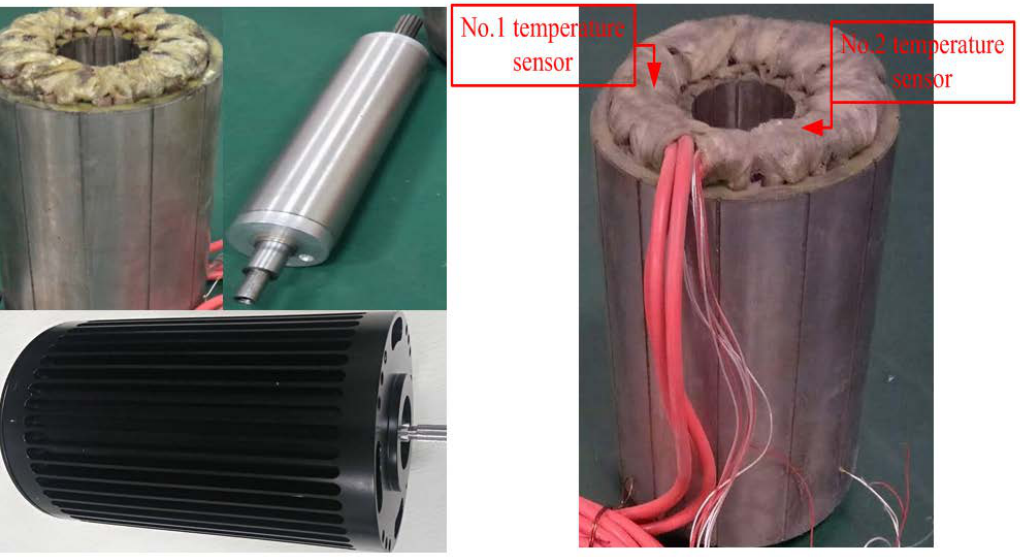
Figure 12. The optimized motor prototype. Energies 2018 , 11 , x FOR PEER REVIEW